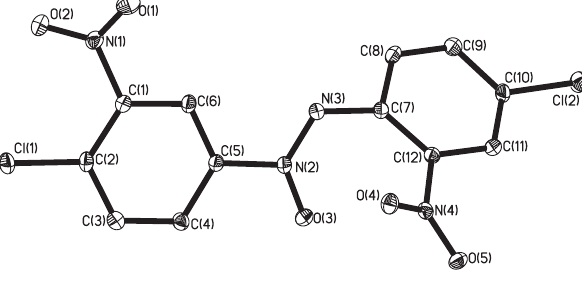
Table 1: Data collection and handling.